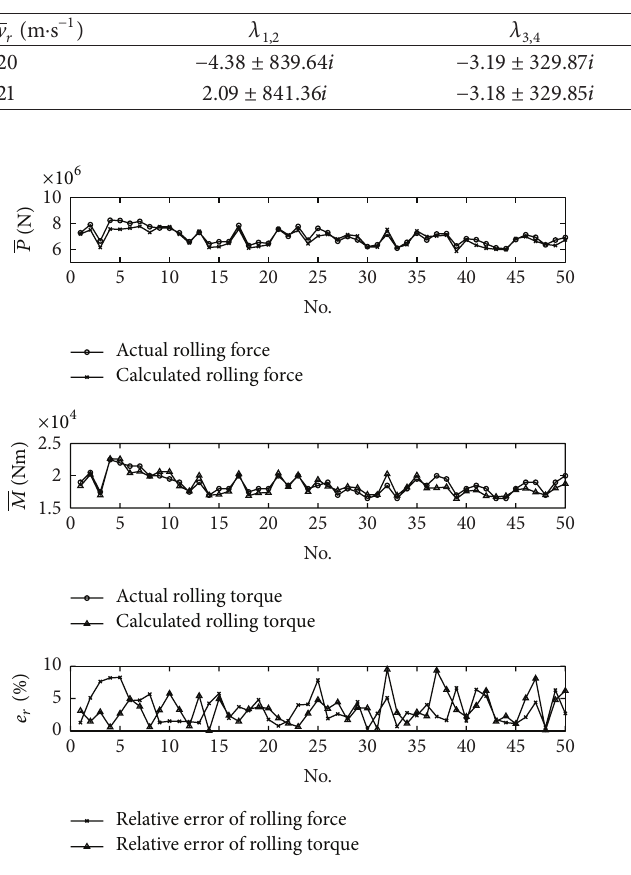
Figure 5: Model validation through comparing calculated results with experimental data.